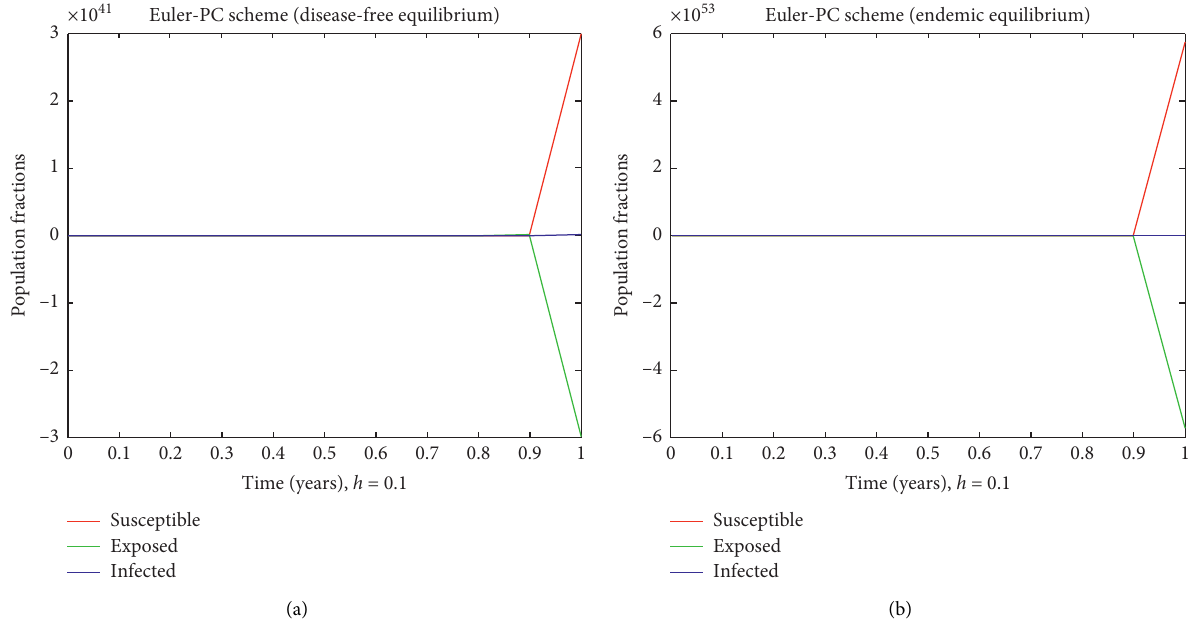
Figure 8: Divergence graphs of the population using the Euler-PC method with step size h � 0 . 1 .